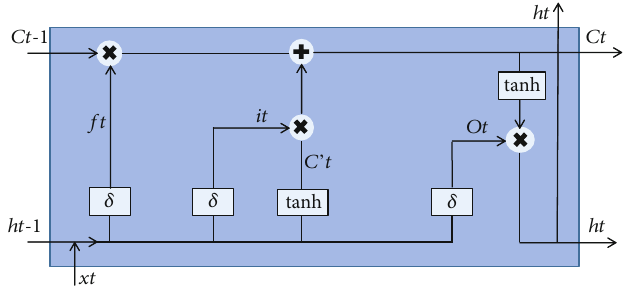
Figure 1: Cell structure of